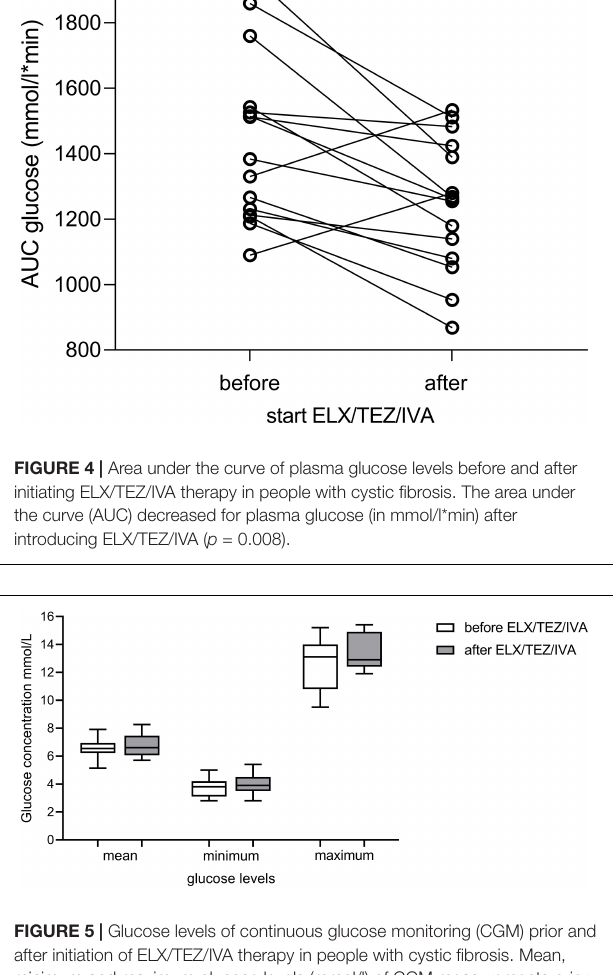
mean improvement in this larger cohort. This is also true for the improvement of sweat chloride